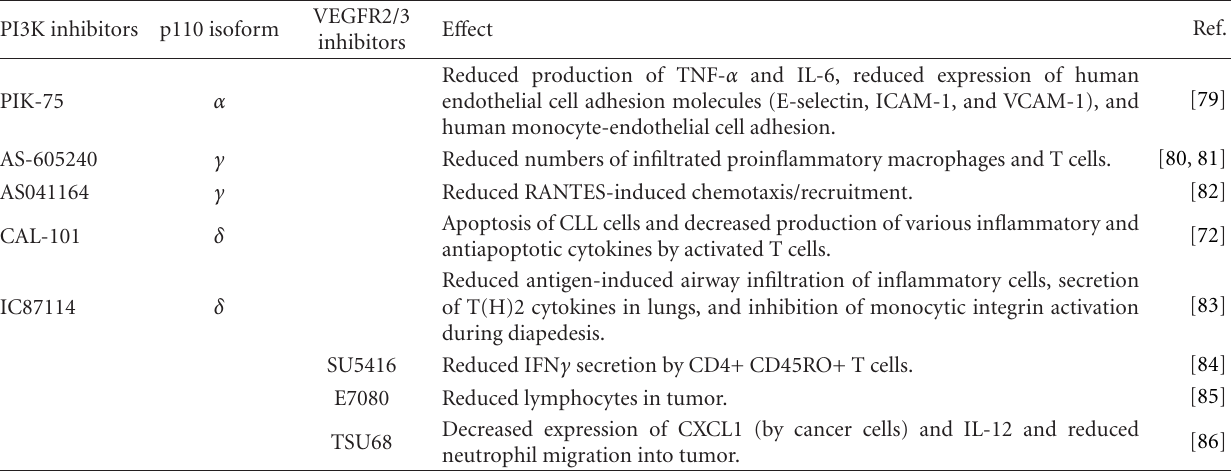
Table 1: Main e ff ects of the PI3K and VEGFR inhibitors on immune cells. VEGFR2/3 PI3K inhibitors p110 isoform